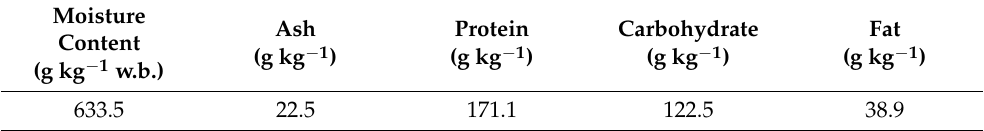
Table 1. The composition of beef sausage.